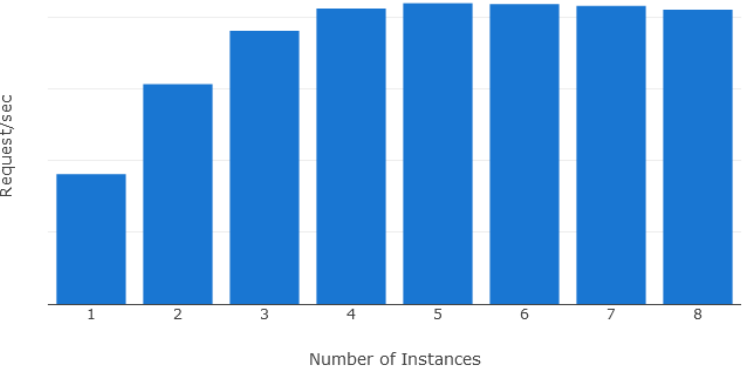
Figure 10. Requests/sec in relation to number of instances.